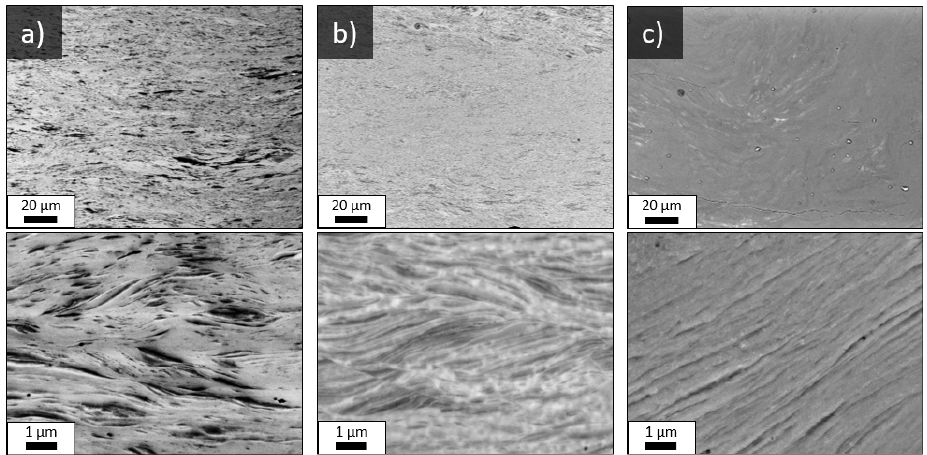
Figure 3. BSE images with two magnifications of HPT-deformed (RT) Fe-SmCo 5 samples at r = 3 mm consisting of ( a ) 10, ( b ) 24 and ( c ) 87 wt.%